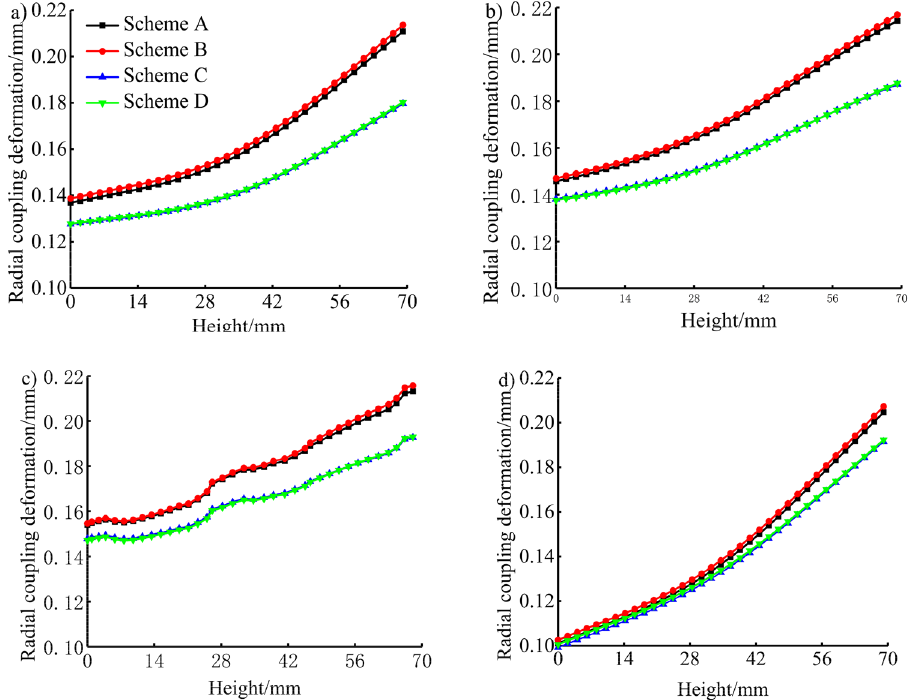
Figure 13. Radial coupling deformation in the axial direction of ( a ) 0° of the piston skirt, ( b ) 30° of the piston skirt, ( c ) 60° of the piston skirt and ( d ) 180° of the piston